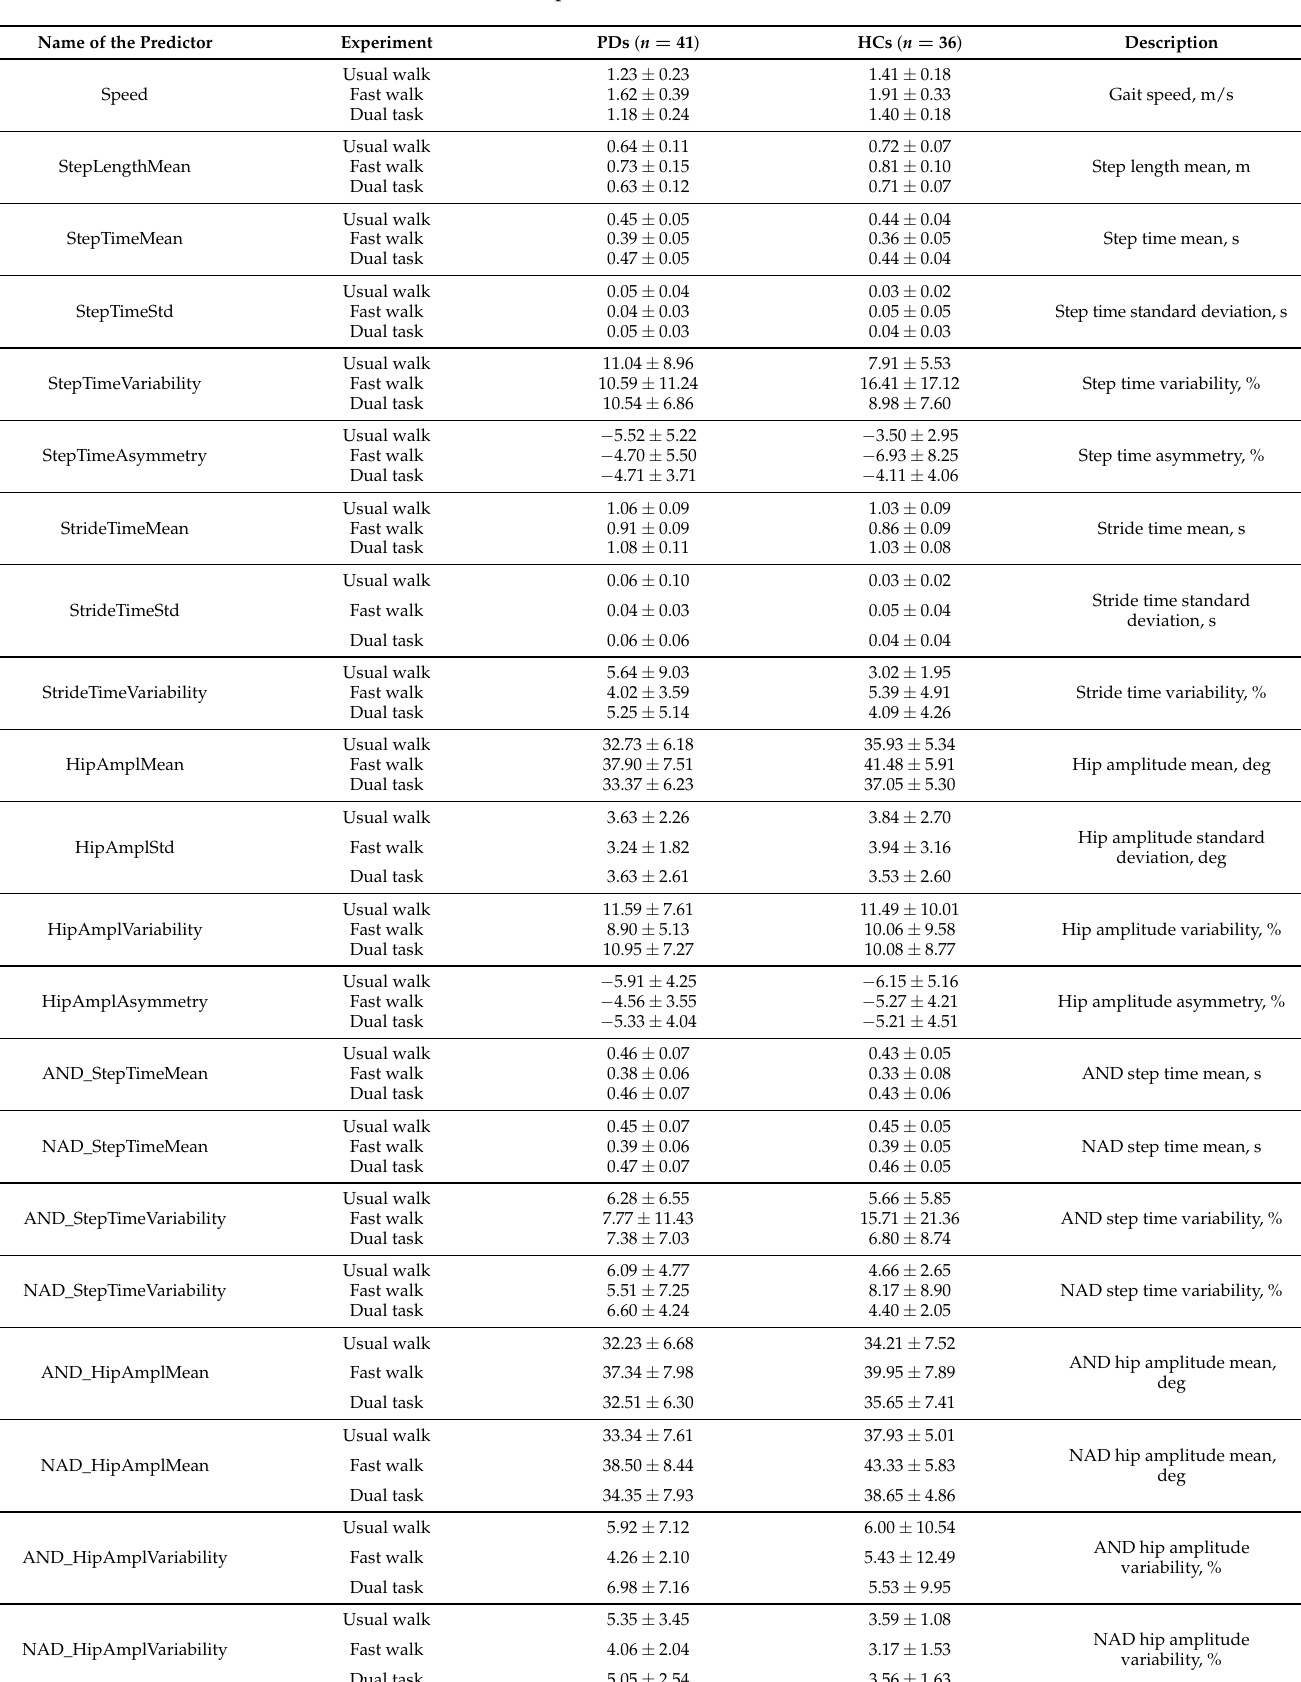
Table A2. Walk-related predictors (mean and SD values, shown as mean ±